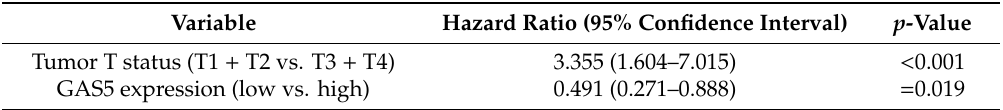
Figure 1. The clinical relevance of GAS5 levels in bladder urothelial carcinoma (BLCA) patients, obtained from the Cancer Genome Atlas (TCGA) database. ( A ) GAS5 mRNA levels in 374 bladder urothelial carcinoma tissues from TCGA were compared between patients with smaller tumors (T1–T2 status) and patients with larger tumors (T3–T4 status); ( B ) GAS5 mRNA gene expression levels in 274 male BLCA patients were compared according to tumor size status; ( C ) GAS5 mRNA gene expression levels in 98 female BLCA patients were compared according to tumor size status. Results were statistically significant by using Student’s t -test; ( D ) Survival analysis was performed for BLCA patients with high (red lines) and low (blue lines) GAS5 gene expression levels, using Kaplan-Meier analysis. The p -value was calculated using a log-rank test. Table 5. Multivariate survival analysis of GAS5 expression and tumor T status in 106 female bladder urothelial carcinoma (BLCA) patients, according to the Cox proportional hazards regression